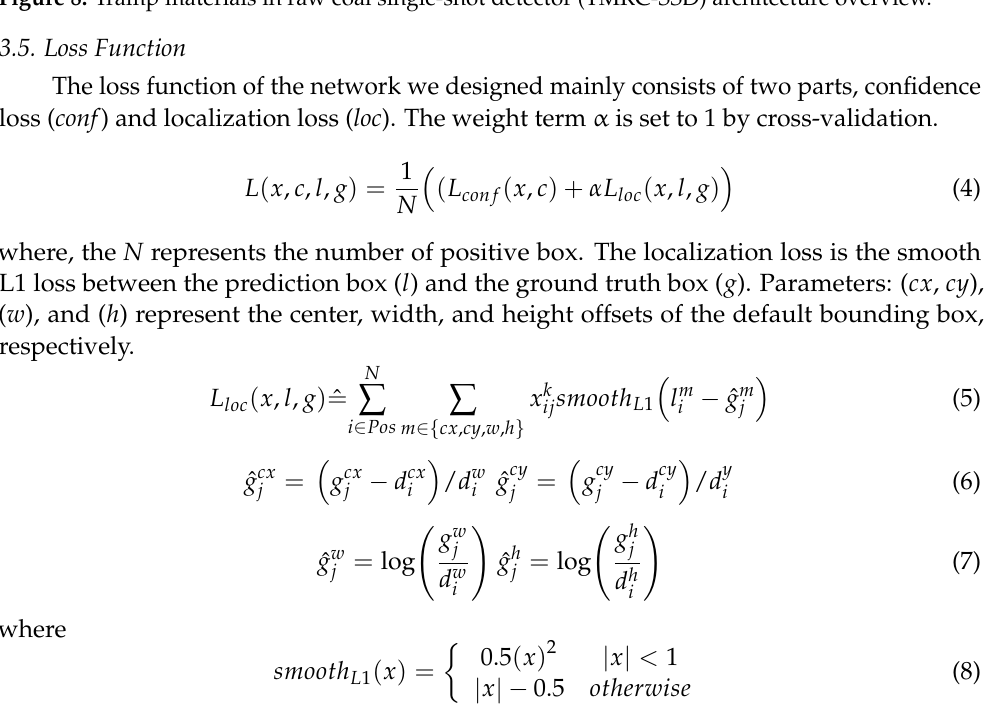
Figure 8. Tramp materials in raw coal single-shot detector (TMRC-SSD) architecture overview.